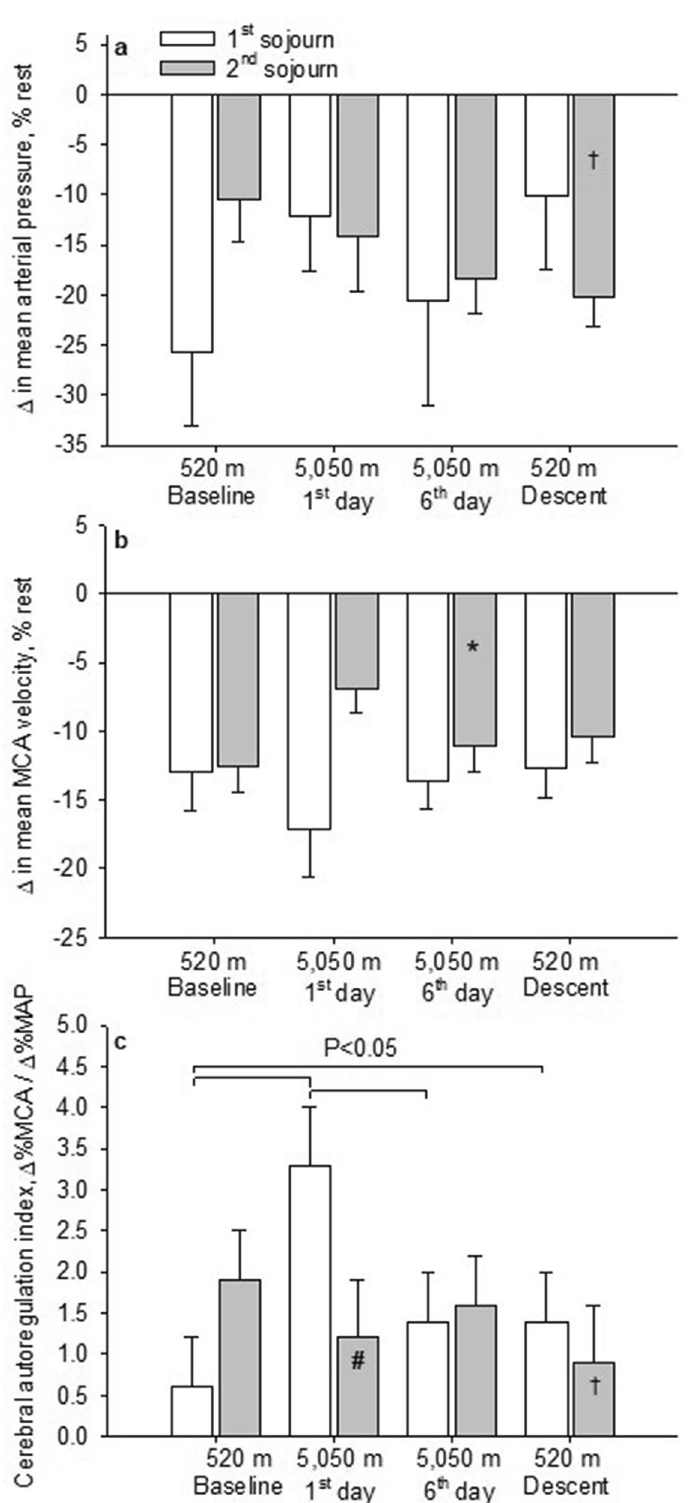
Figure 2. Cerebral autoregulation index assessed during a sit-to-stand maneuver. Panel ( A ) Mean arterial pressure (MAP) percentage change between standing versus sitting. Panel ( B ) Mean middle cerebral artery peak blood velocity (MCAv) percent change between standing versus sitting. Panel ( C ) Cerebral autoregulation index calculated by Δ%MCAv/Δ%MAP with a sit-to-stand maneuver. Standing values were obtained by averaging 15 beats following standing up < 1 s. # P < 0.05 between the acute altitude-induced effect during the 2nd compared to the 1st sojourn; * P < 0.05 between the acclimatization effect during the 2nd compared to the 1st sojourn; † P < 0.05 between the descent effect during the 2nd compared to the 1st